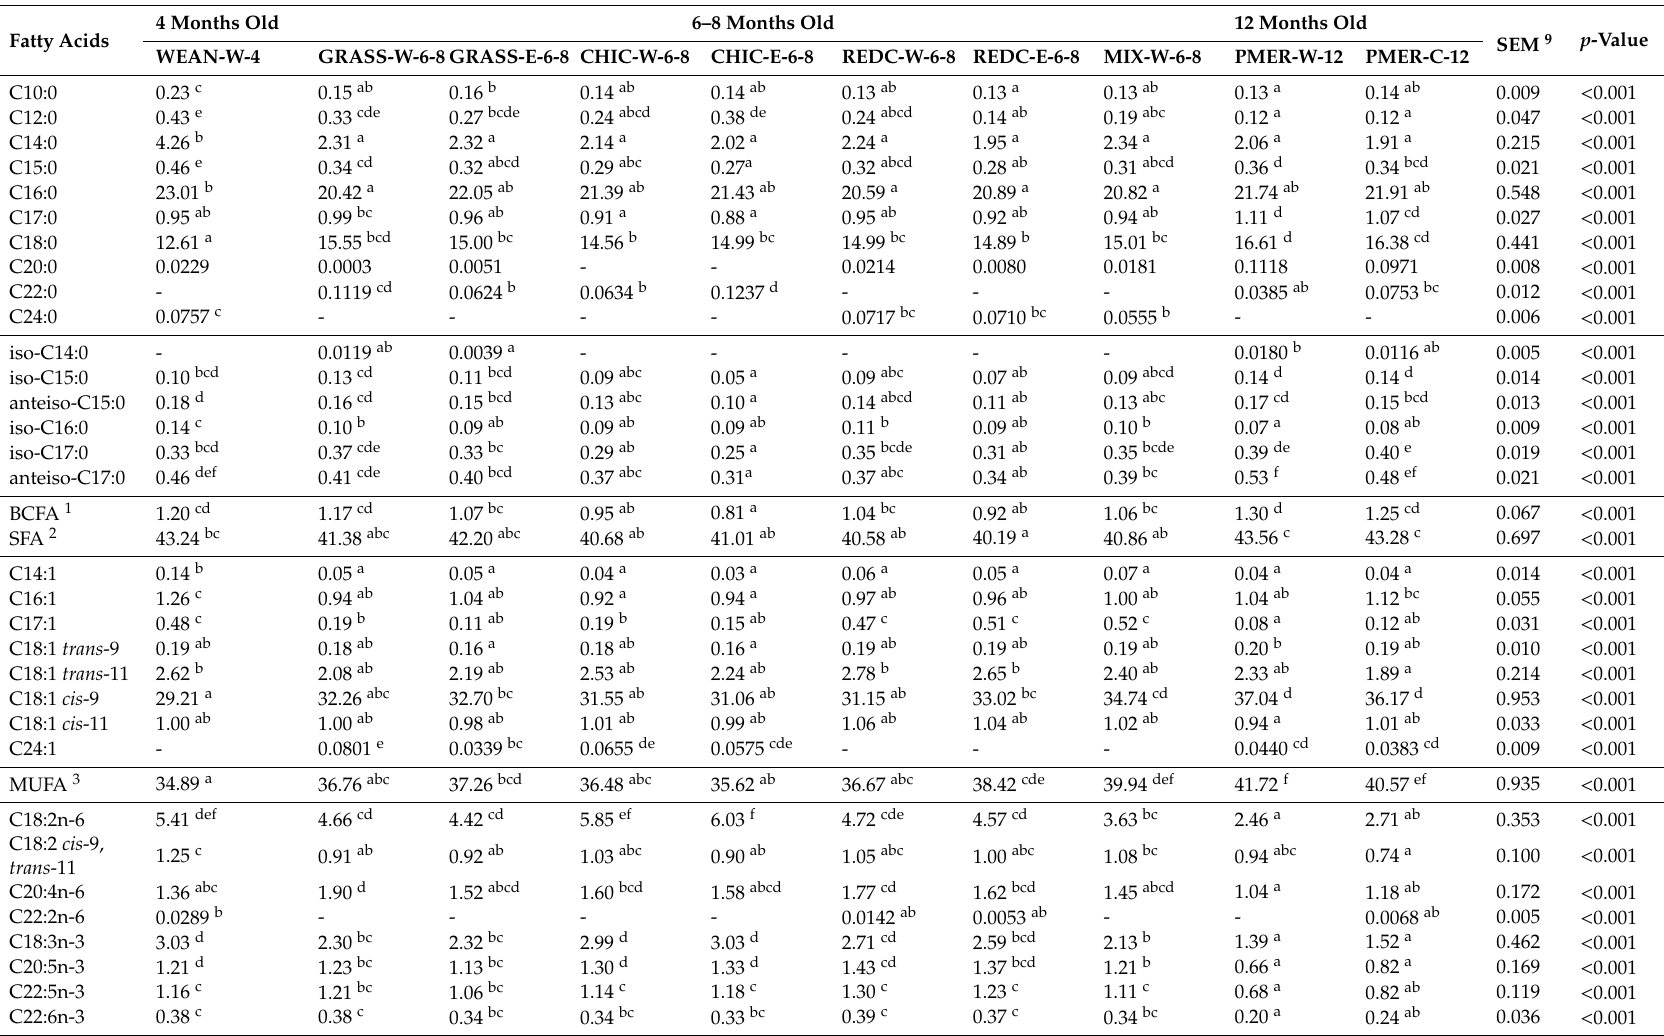
Table 3. Fatty acid composition of Longissimus thoracis as a percentage of total fatty acids from lambs reared under di ff erent New Zealand commercial production systems. Fatty